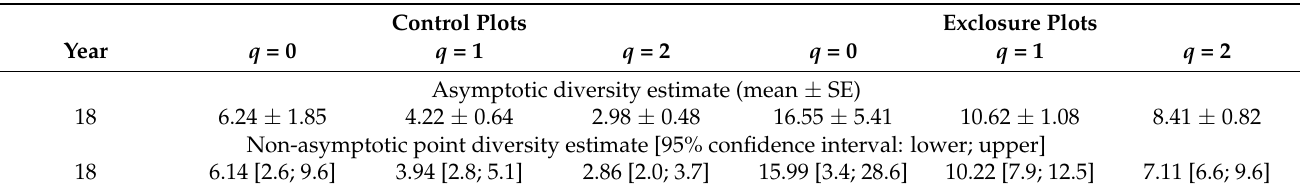
Table 3. Asymptotic and non-asymptotic diversity estimates for incidence-based tree species data of top height individuals collected on control and exclosure plots in Austria 18 years after establishment of study plots. Non-asymptotic rarefaction and extrapolation analyses are based on point diversities for a specified sample coverage of Cmax = 98.8%. Numerical values for Hill numbers of order q ( q = 0, species richness; q = 1, Shannon diversity; q = 2, Simpson diversity). Control Plots Exclosure Plots Asymptotic diversity estimate (mean ±